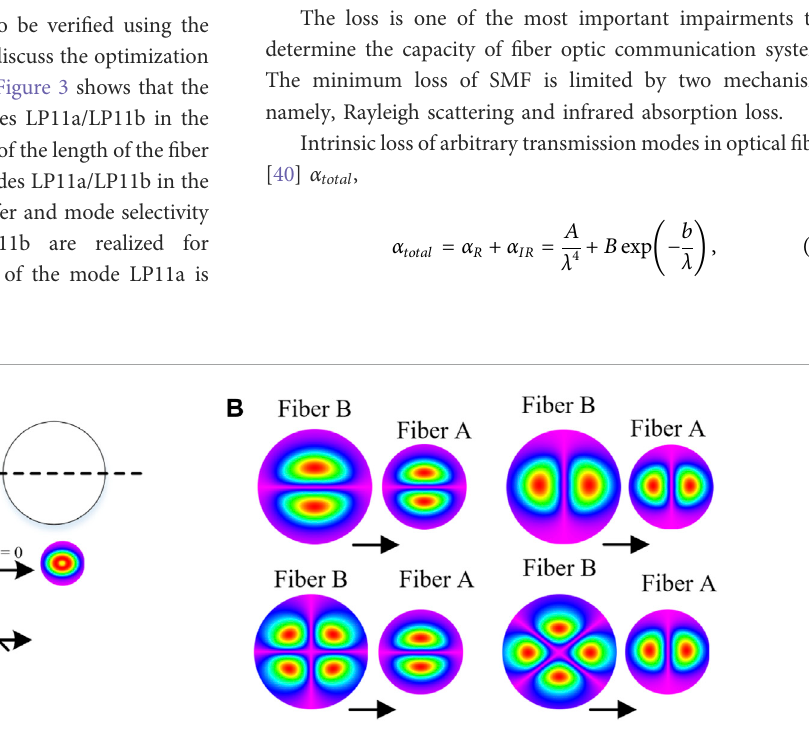
FIGURE 2 (De)multiplexing principle with the directional coupling method. (A) Illustration of conventional MUX/DEMUX. (B) Illustration of our proposed MUX/DEMUX.